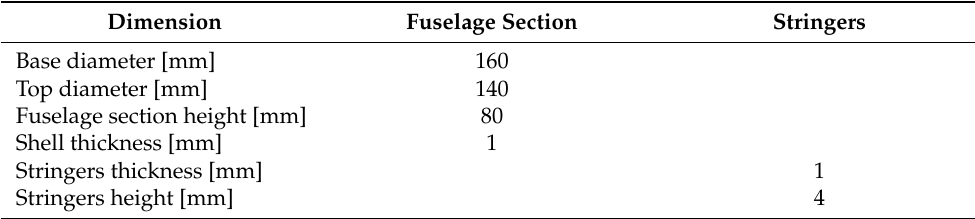
Table 1. Dimensions of fuselage section and stringers subjected to compression test.